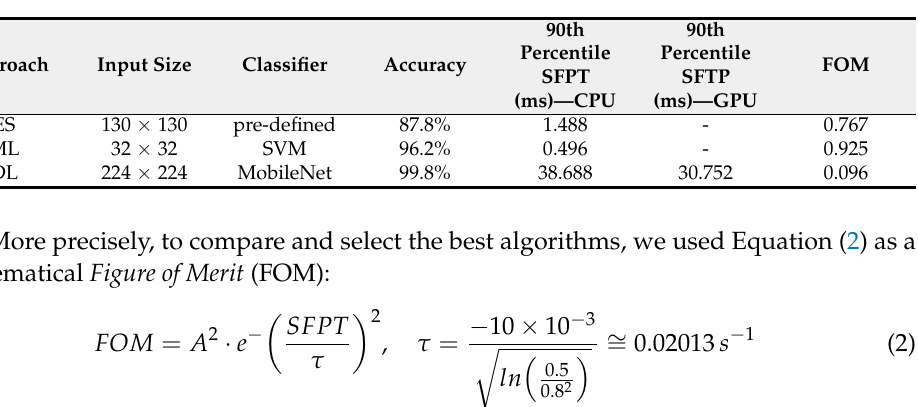
Table 7. Classification accuracy and speed performance comparison across the three investigated